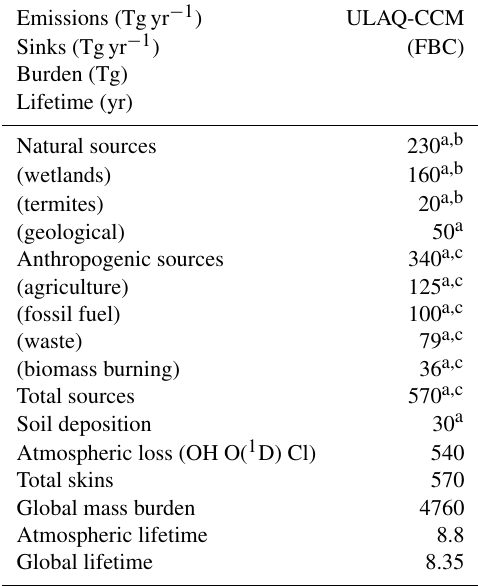
Table 5. CH 4 surface emissions, sinks, global mass burden and life- time in the ULAQ-CCM for experiment (b) (year